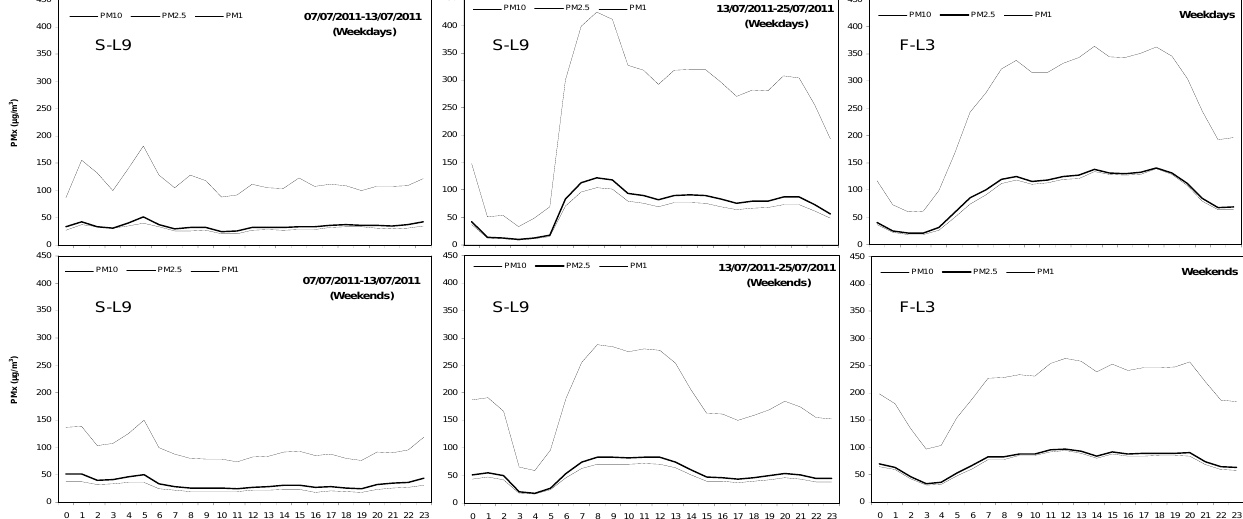
Fig. 5. Mean hourly PM 10 , PM 2 . 5 and PM 1 levels recorded during the study period at Fontana (F-L3), and during the first and last measure- ment periods at Sagrera stations (S-L9).